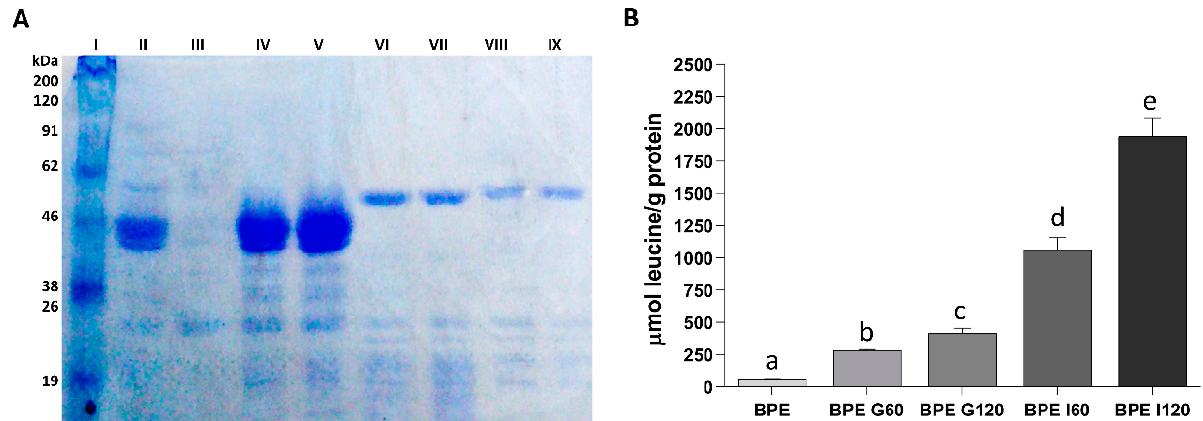
Figure 2. SDS-PAGE and degree of hydrolysis of bean proteins after the different steps of in vitro digestion. ( A ) SDS-PAGE of Pinto bean protein extract. Molecular weight marker is shown in lane 1. Protein pattern of Pinto bean protein extract is shown in lane 2. Sample after 60 min of gastric digestion is shown in lane 4. Sample after 120 min of gastric digestion is shown in lane 5. Sample after 60 min of intestinal digestion is shown in lane 6. Sample after 120 min of intestinal digestion is shown in lane 7. Samples after 60 and 120 min of control digestion with digestive enzymes but without bean proteins are shown in lane 8 and 9, respectively. ( B ) The amount of free amino groups released during the different phases of in vitro gastrointestinal digestion of Pinto bean protein extract. Results were expressed as μ mol of leucine equivalent per g of the initial amount of proteins. Values represent means ± SD of triplicate digestions. Different letters indicate that the values are significantly different ( p < 0.05). BPE: Pinto bean protein extract; BPE G60: Pinto bean protein extract after 60 min of gastric digestion; BPE G120: Pinto bean protein extract after 120 min of gastric digestion; BPE I60: Pinto bean protein extract after 60 min of intestinal digestion; BPE I120: Pinto bean protein extract after 120 min of intestinal digestion.